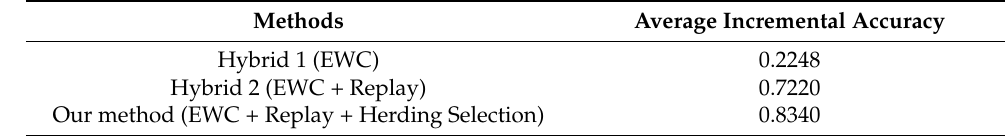
Table 5. Ablation analysis of average accuracy